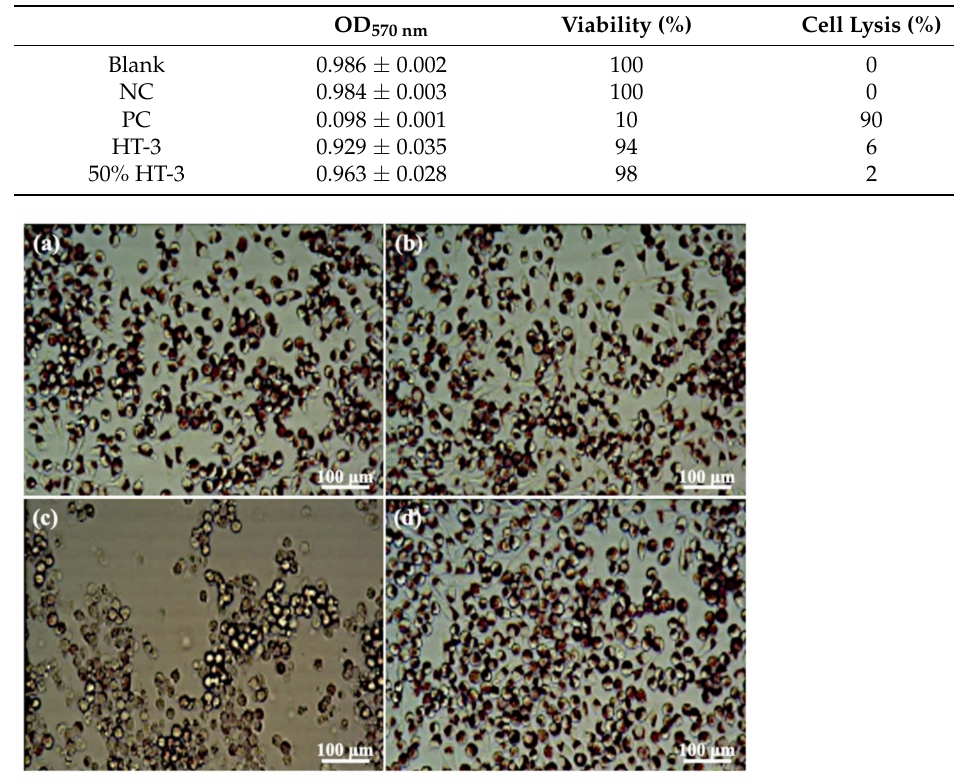
Figure 8. Optical images of the cell morphologies on the investigated samples: ( a ) blank, ( b ) negative control, ( c ) positive control, and ( d ) HT-3.